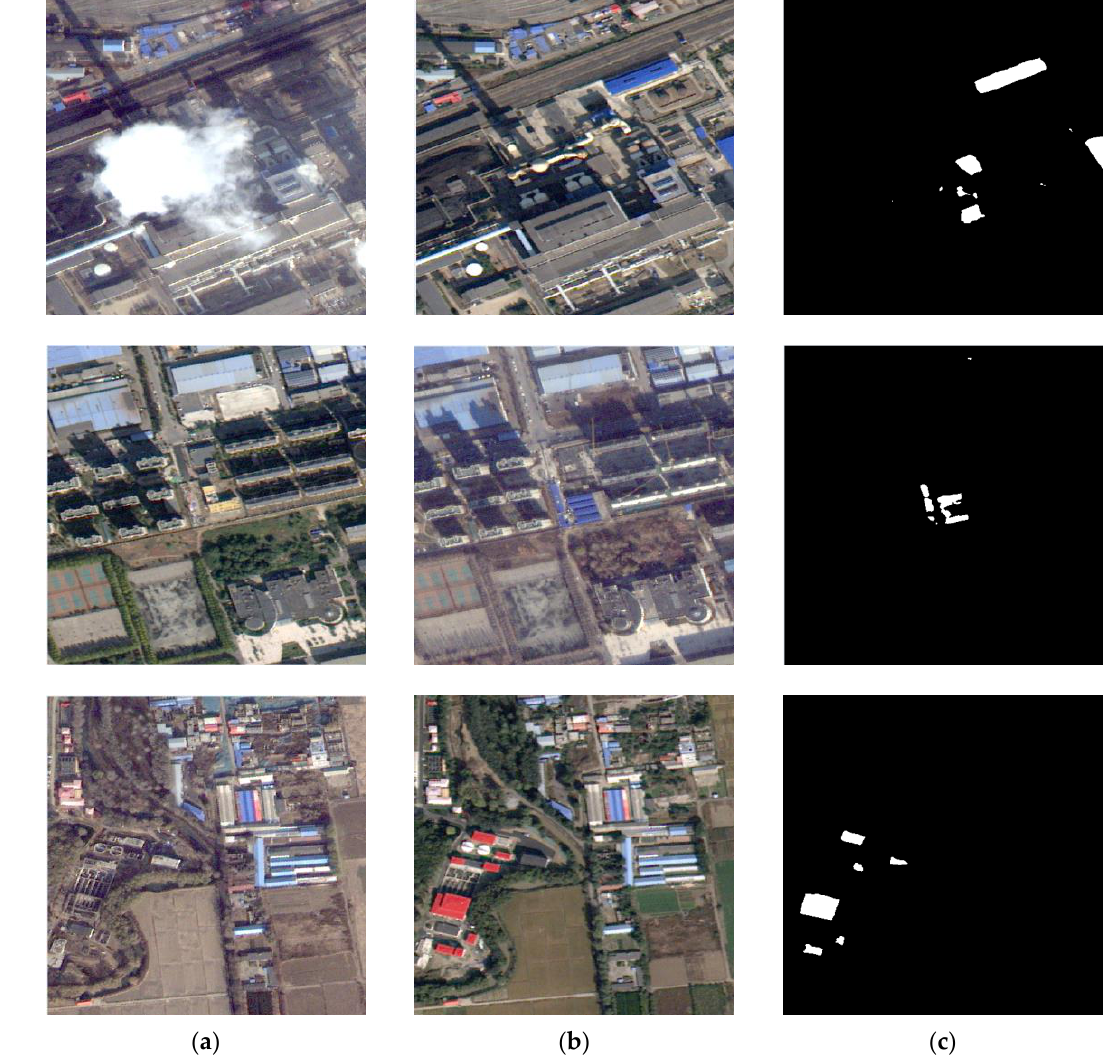
Figure 9. Results on other image pairs. ( a ) Before images; ( b ) after images; ( c ) results of the proposed method.